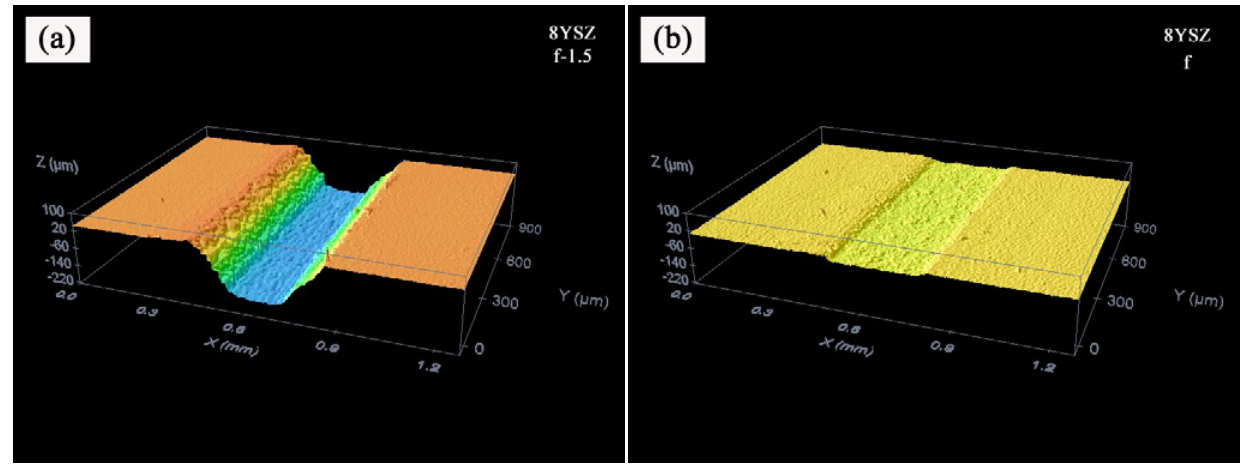
Figure 5. Topographies and profiles for 8YSZ substrates machined by grooves, − 1.5 mm out of focus ( a ); and at focus ( b